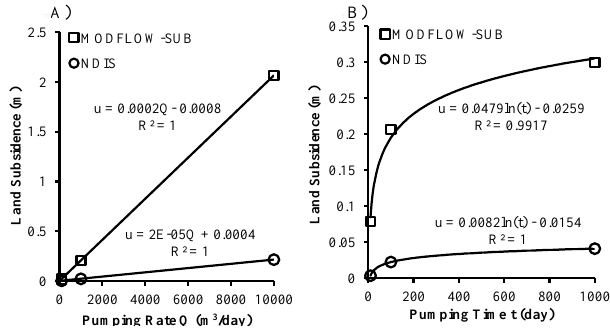
Figure 4. Sensitivity comparison using NDIS and MODFFLOW- SUB models. (a) Land subsidence vs. pumping rate. (b) Land sub- sidence vs. pumping